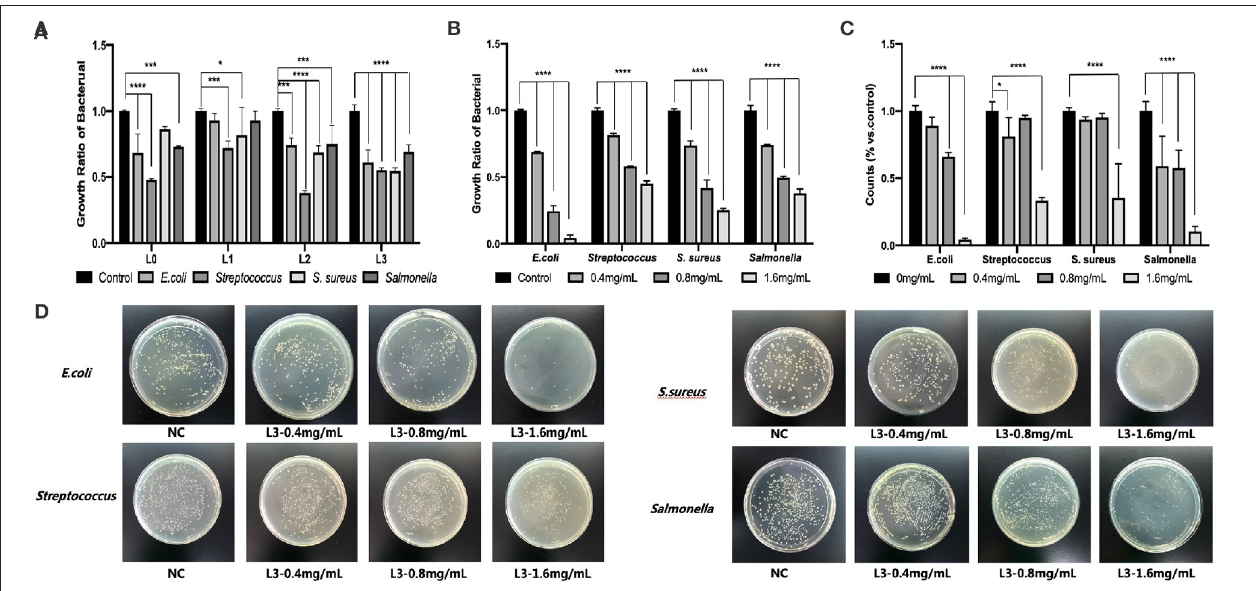
FIGURE 4 | The antimicrobial behavior of lignin fractions by the microdilution method (A) , effect of different lignin concentrations of L3 on antimicrobial ability by the microdilution method (B) and by the agar media method (C) , effect of different lignin concentrations of L3 on the colony of different bacteria (D) (* p < 0.05; *** p < 0.001; and **** p <